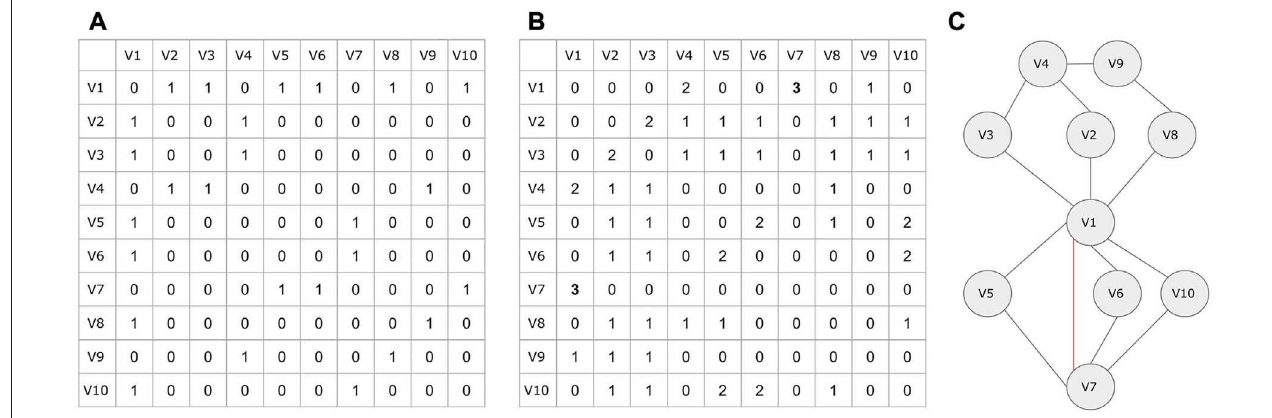
FIGURE 14 | A triangle closing link prediction example. (A) The adjacency matrix of the undirected, unweighted example network. (B) The algebraic representation of the A 2 matrix. Each ( i,j ) value represents the number of common neighbors of the nodes i and j . (C) The example network plot. The red edge represents the new predicted link in time point t + 1